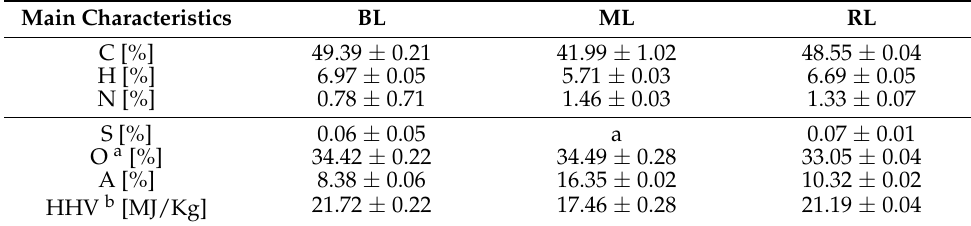
Table 1. The main characteristics of leaves. Main